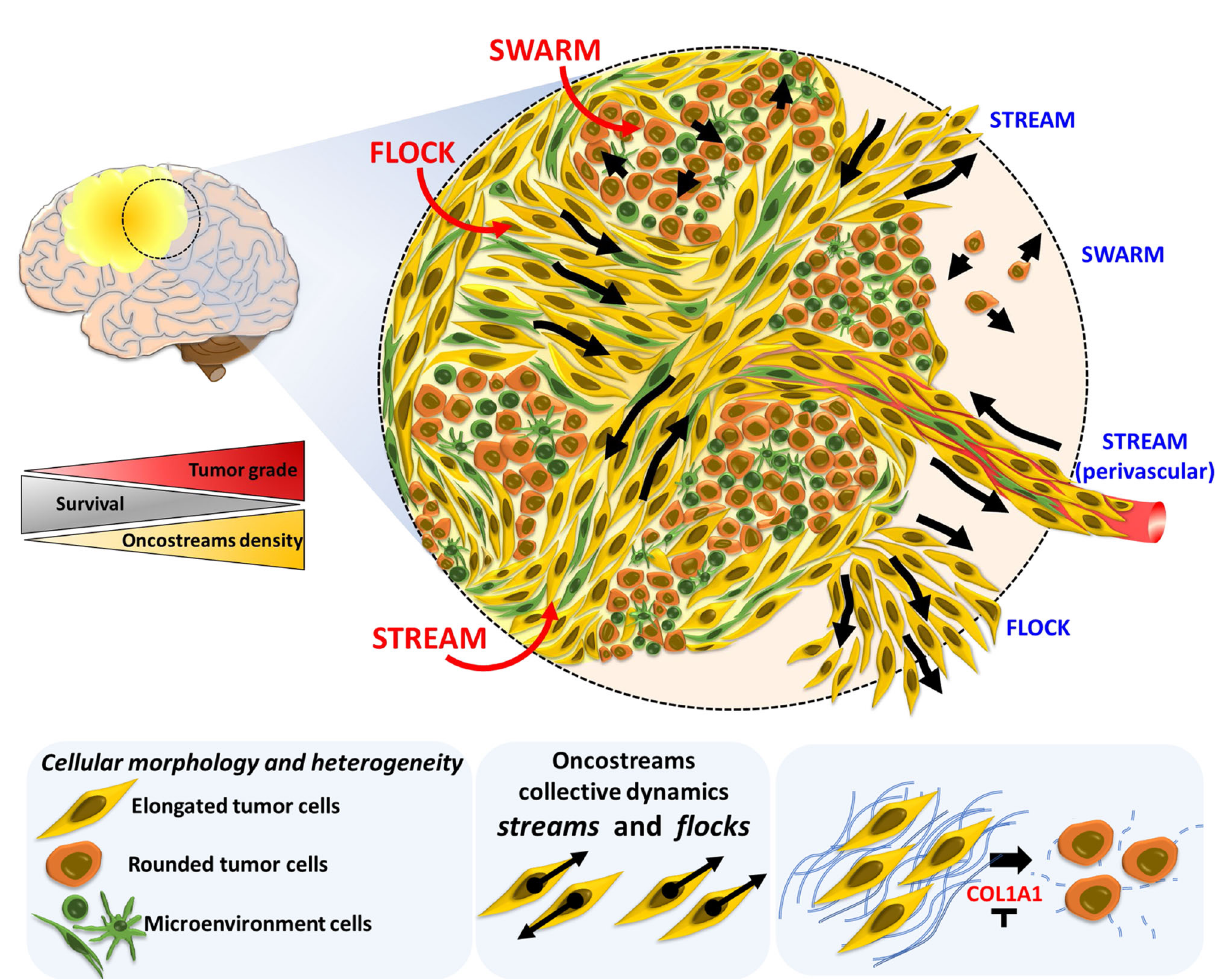
Fig. 10 Oncostreams are COL1A1-rich multicellular dynamic mesenchymal structures that regulate glioma migration and malignant behavior. Summary representation of mesenchymal dynamic fascicles (oncostreams) present in high grade gliomas. Our study reveals that oncostreams display directional collective motility patterns including streams and fl ocks. Non-directional collective motion (swarms) are represented by round cells that move without a preferred direction of motion. Directional dynamic patterns function as tumoral highways to facilitate the intra-tumoral spread of cells and potentially participate in the local invasion of normal brain. Red shows patterns of migration within the tumor core, and blue marks the patterns at the tumor invasive border. Oncostreams are areas of mesenchymal transformation de fi ned by a molecular signature enriched in COL1A1. COL1A1 knockdown disrupts oncostream organization, decreases intratumoral heterogeneity, and signi fi cantly increases animal survival. Our study reveals that oncostreams are anatomically and molecularly distinctive, are areas of mesenchymal transformation organized through interactions with the COL1A1 matrix, move by collective motion, and regulate glioma aggressiveness. Figure was created by the